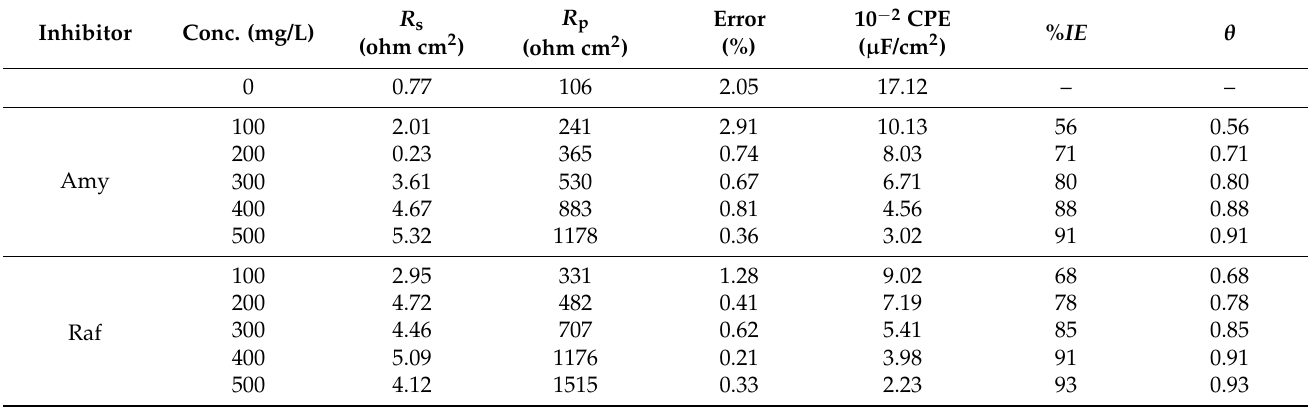
Table 3. EIS results for Al corrosion in 0.1 M NaOH medium and with Amy and Raf at 298 K. Inhibitor